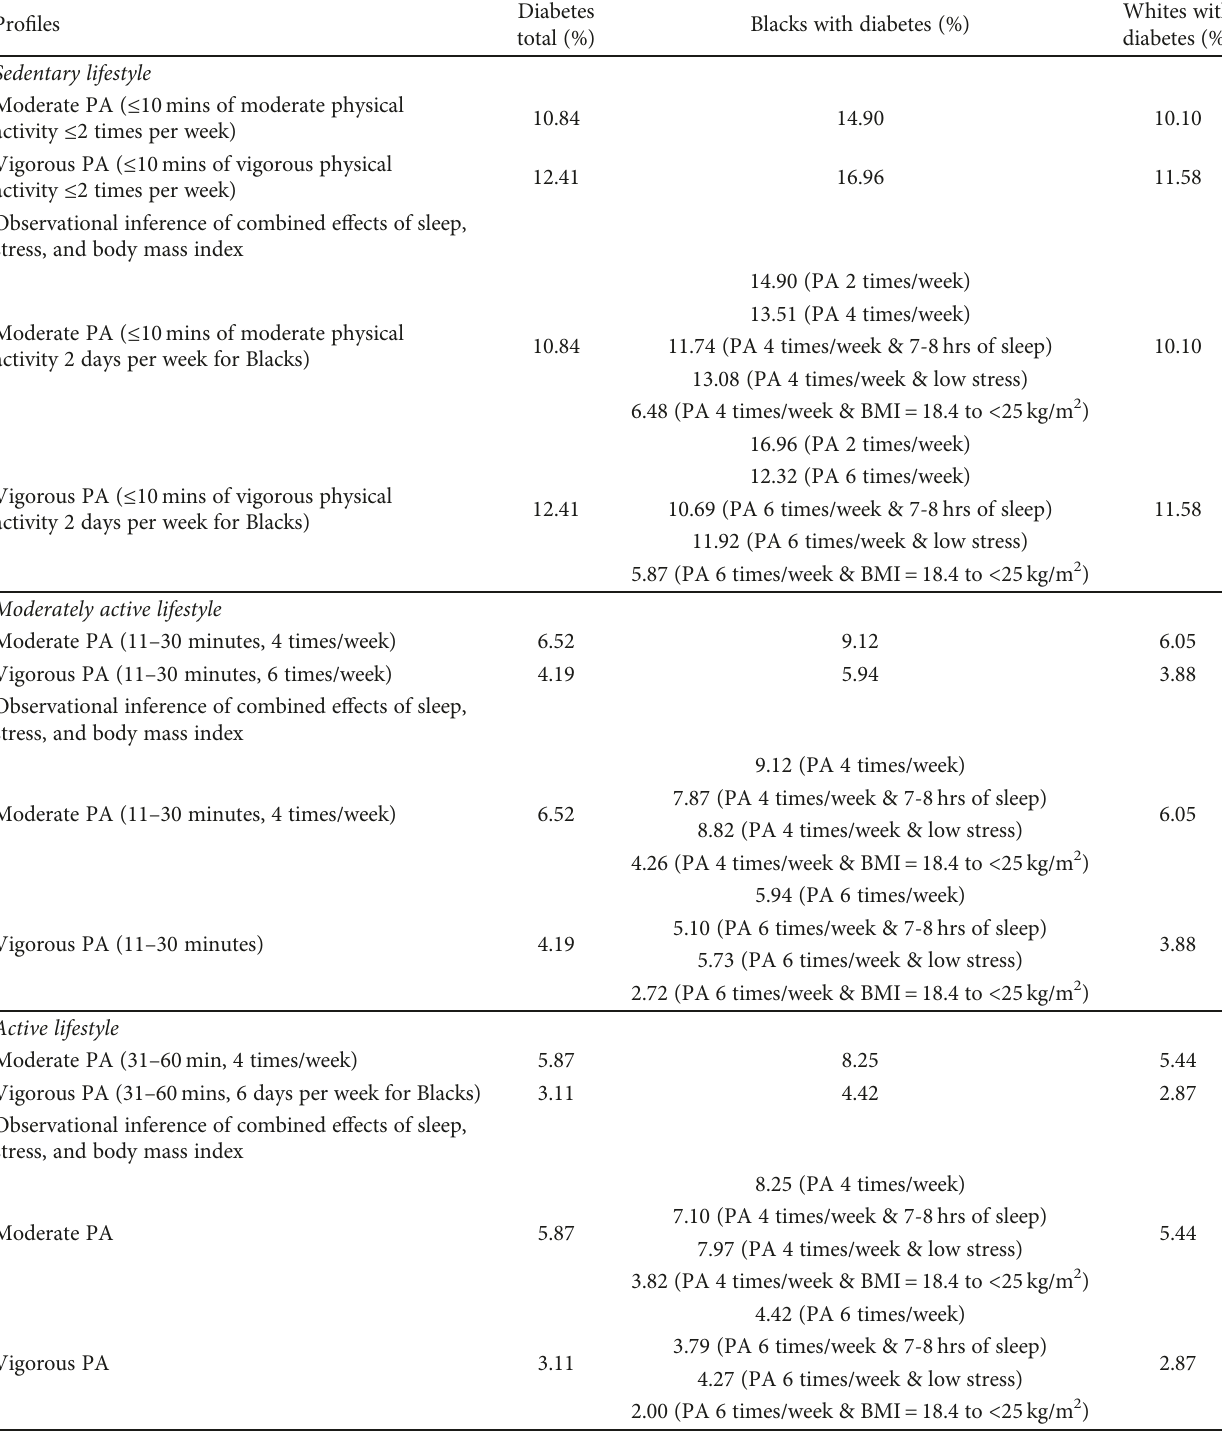
Table 2: Observational inference of physical activity lifestyles and the combined e ff ects of sleep, stress, and body mass index on diabetes in Blacks and